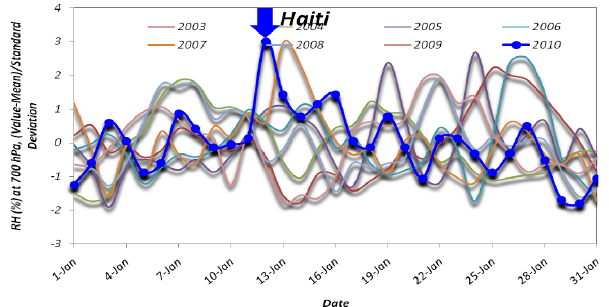
atmosppheric perturbations. .